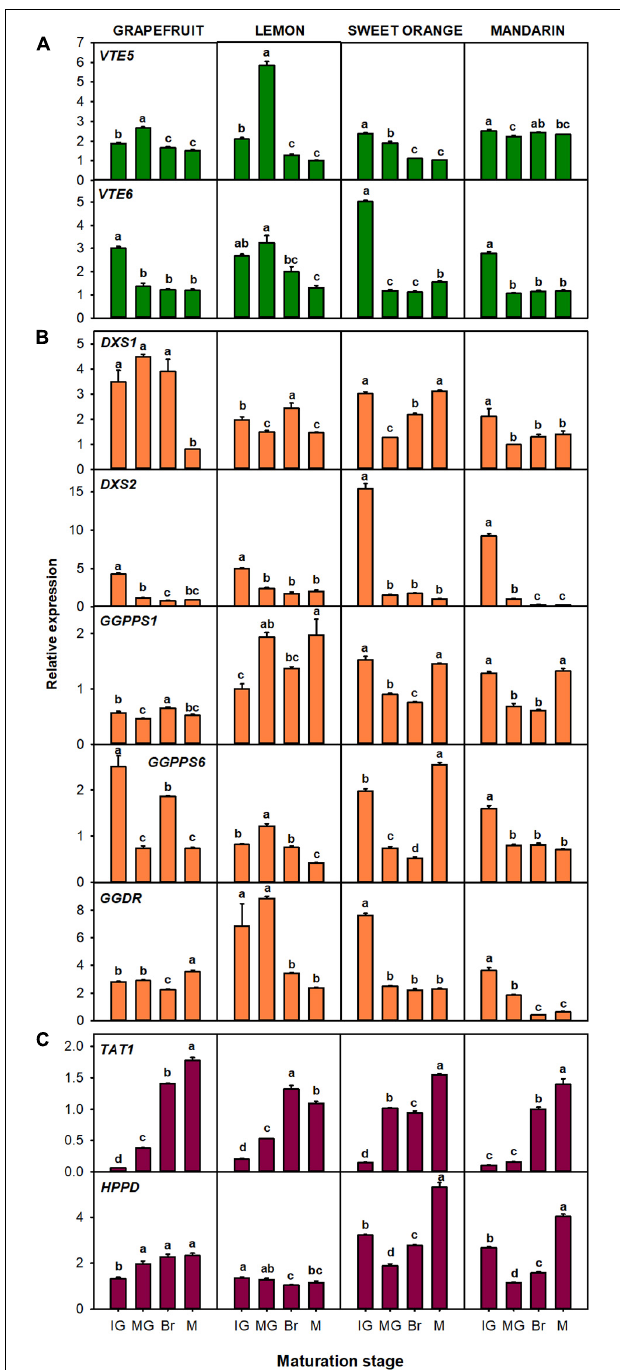
FIGURE 4 | Relative expression of genes involved in the synthesis of precursor PPP (phytyl pyrophosphate), through the recycling of free phytol (A) and MEP pathway (B) , and of precursor HGA (homogentisate) through the SK pathway (C) , in the flavedo during fruit maturation of grapefruit ( C. paradisi ), lemon ( C. limon ), sweet orange ( C. sinensis ), and mandarin ( C. clementine ). The genes analyzed were VTE5 (phytol kinase), VTE6 (phytyl-P kinase), DXS1 and DXS2 (1-deoxy- D -xylulose-5-phosphate synthase 1 and 2), GGPPS1 and GGPPS6 (geranylgeranyl pyrophosphate synthase 1 and 6),